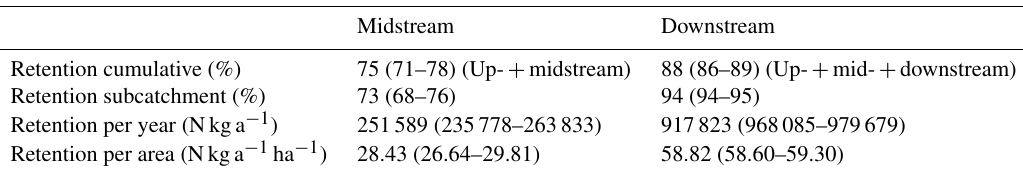
Table 3. Nitrogen retention potentials derived for the midstream and downstream subcatchment based on flow-normalized fluxes. Numbers in brackets refer to the 5th and 95th percentiles of the WRTDS flux